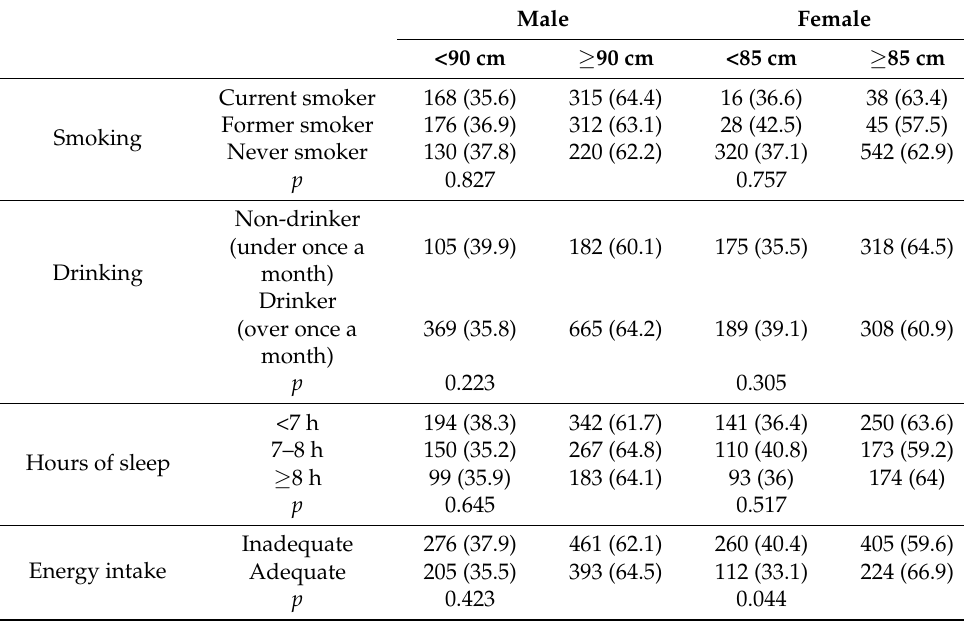
Table 2. Comparison of waist circumferences between males and females by health behavioral characteristics